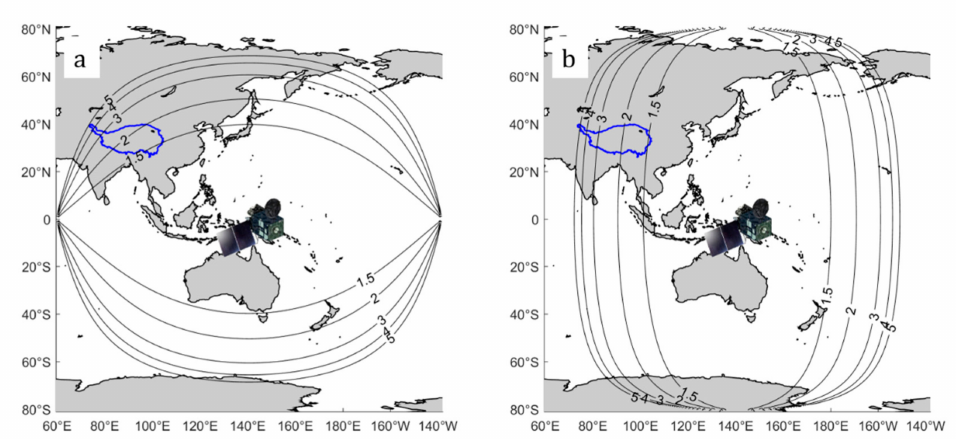
Figure 15. The rate of Himawari–8 AHI’s pixel size expansion in the north–south ( a ) and west–east ( b )